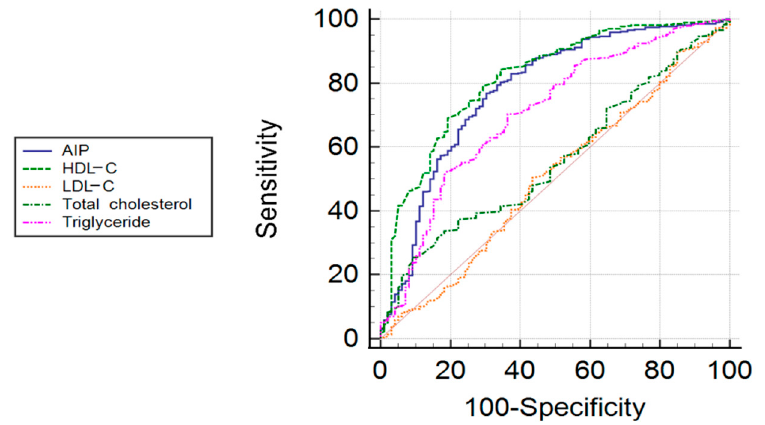
Figure 2. Receiver operating characteristic curve for specific lipid fractions to detect OSA.